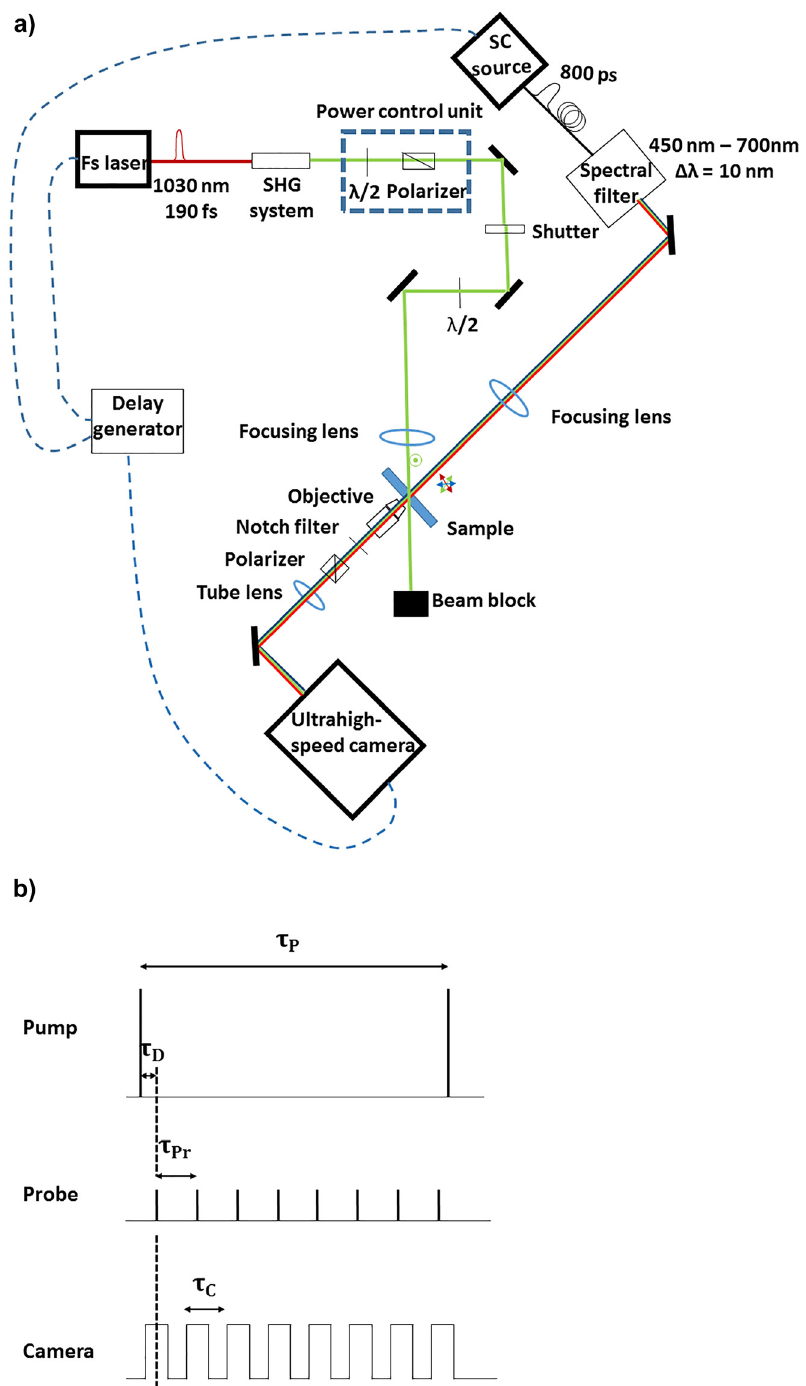
pulse.Onepumppulseisalwaysfollowedbyaprobepulsetrainwitha